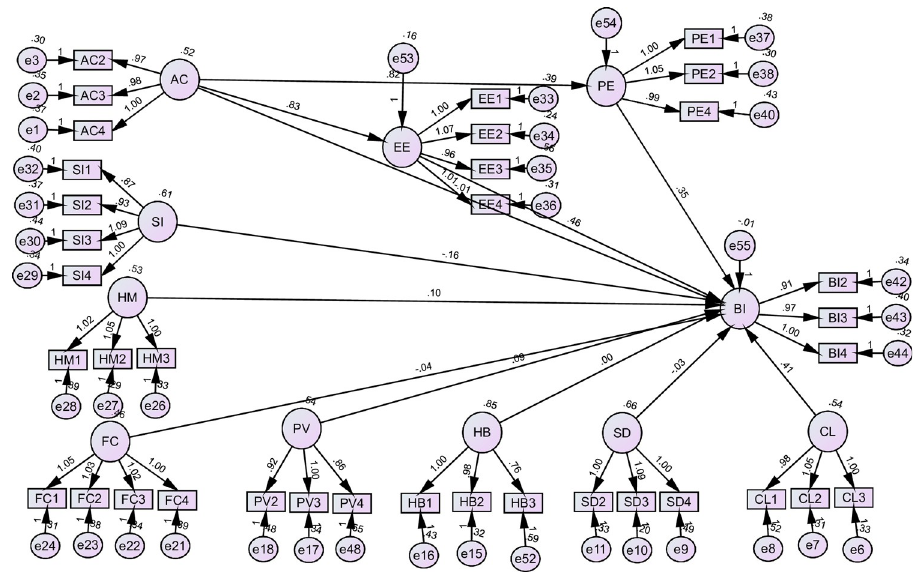
Fig 2. SEM analysis for Poland.